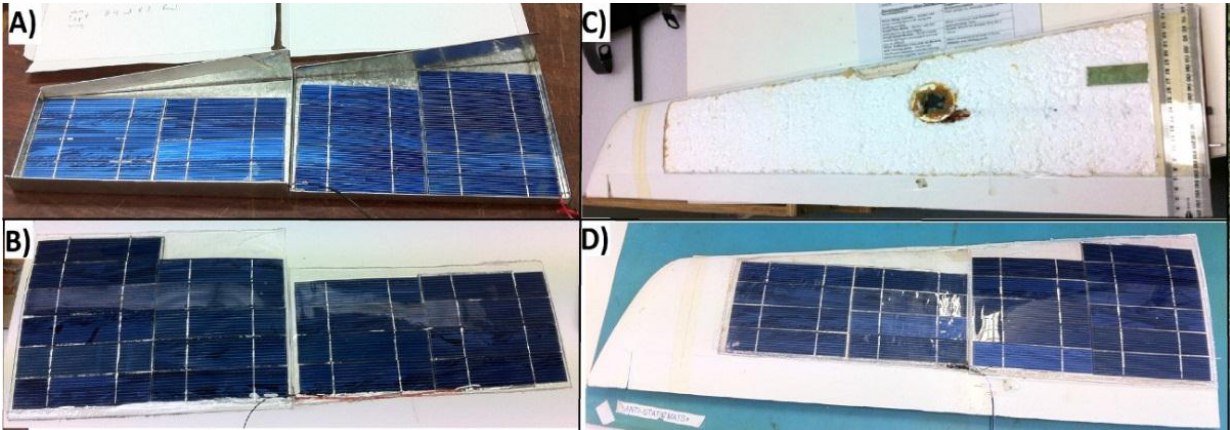
Figure 13. Solar powered wing construction: ( A ) left wing SSC panel in the mold; ( B ) right wing SSC panel encapsulated with clear and flexible resin; ( C ) left wing peeled on the skin to accommodate the solar panel; ( D ) final installation of the SSC panel on the surface of the